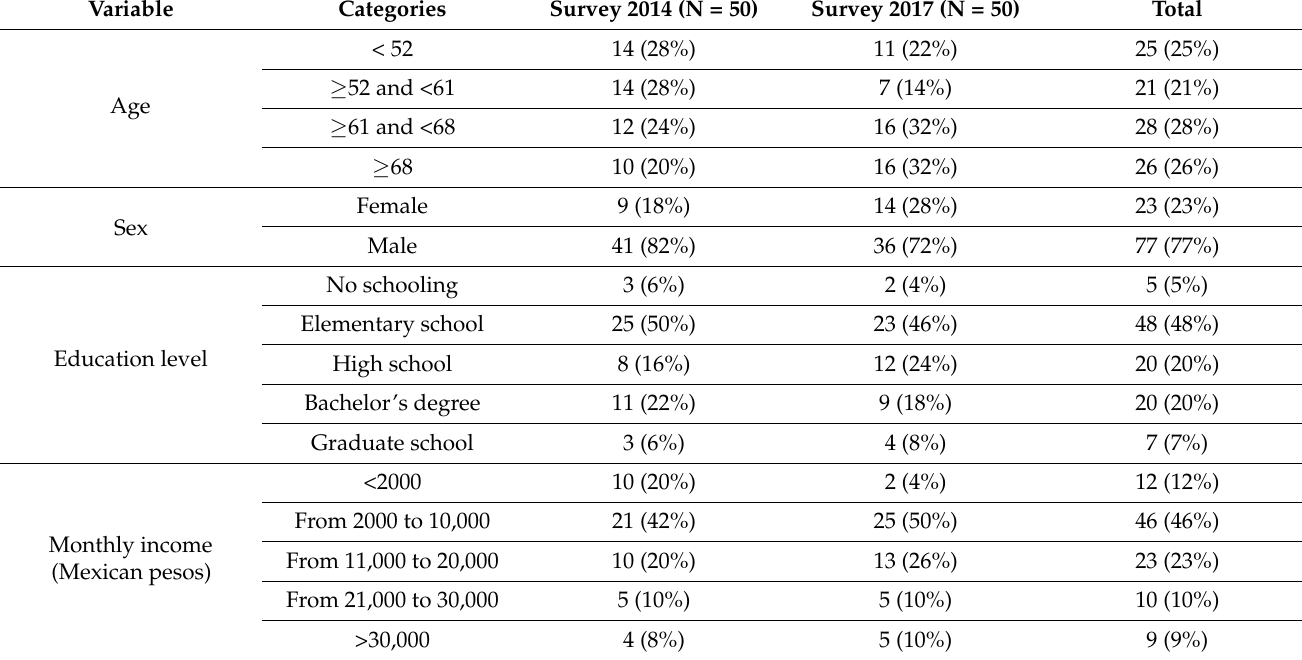
Table 4. Demographics and socioeconomic attributes of the